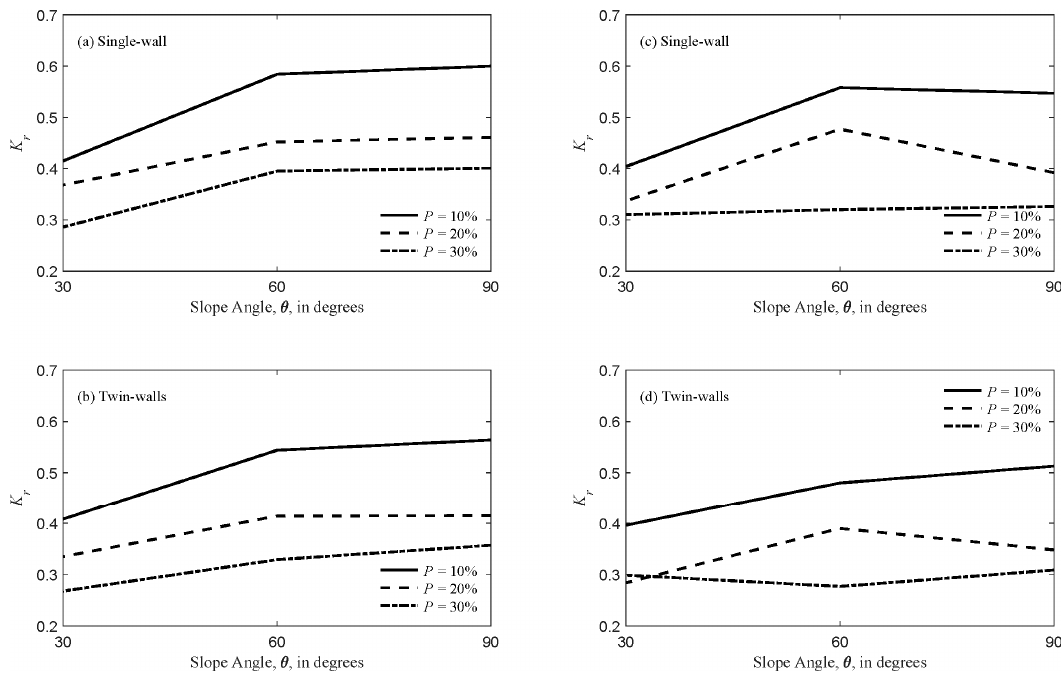
Figure 15. Variation of K r with θ for d / L p = 0.2733, and different porosities and wall configurations. On the left, H is / d = 0.2493 ( a and b ) and on the right H is / d = 0.1284 ( c and d ).